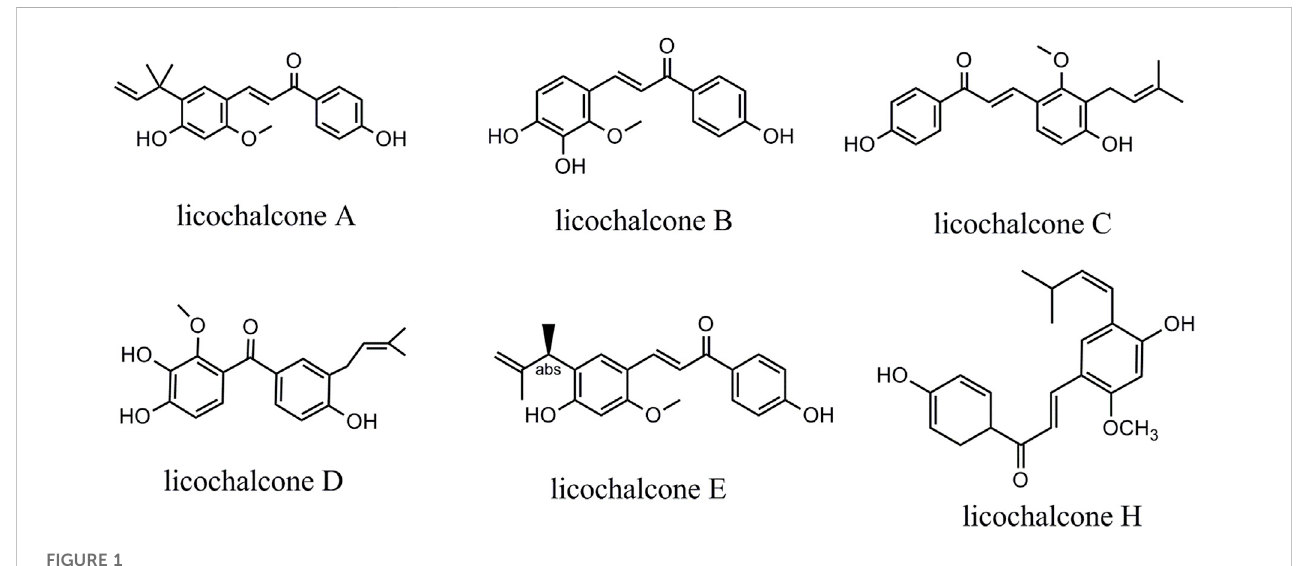
FIGURE 1 Chemical structure of